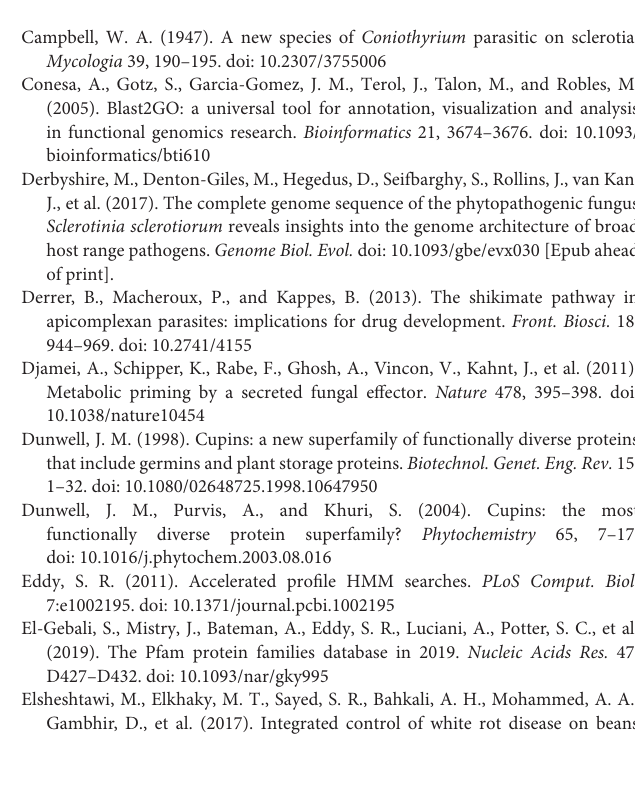
TABLE S2 | GO categories analysis of the DEGs of S. sclerotiorum during mycoparasitism process induced by C. minitans ( p ≤ 0.05). The GO classification was conducted on the online website of FungiFun (https://sbi.hki-jena.de/fungifun/fungifun.php) based on GO ontology database of the fungi species of S. sclerotiorum . TABLE S3 | Enrichment of FunCat categories of the DEGs in S. sclerotiorum ( p ≤ 0.05). The classification of FunCat categories was conducted on the online